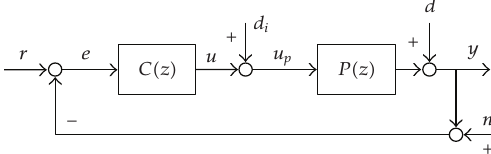
Figure 1: Configuration of feedback